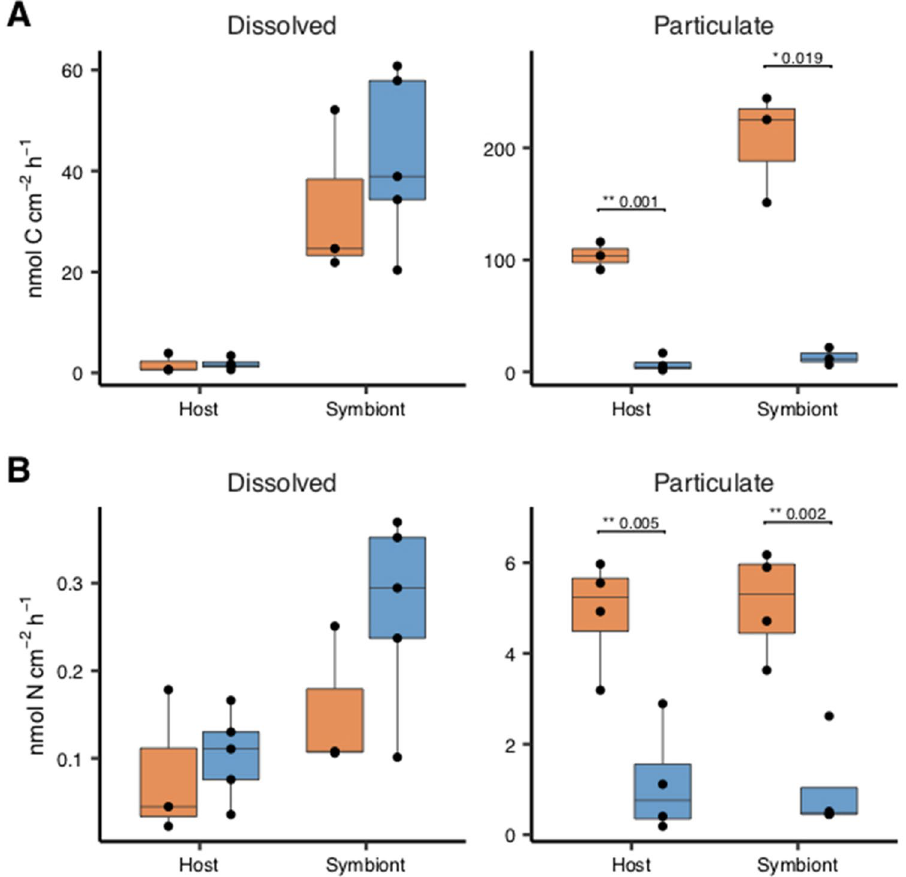
Figure 4. Carbon (top panel) and nitrogen (bottom panel) assimilation rates in the coral host tissue and algal symbionts via heterotrophy. Colonies originate from 30 m (’Deep’, blue boxes) and 2 m (’Shallow’, red boxes) water depth. Horizontal black lines within boxes are median values and box limits represent 1st and 3rd quartiles. Whiskers represent 1.5 times the interquartile range. Round black points are individual sample